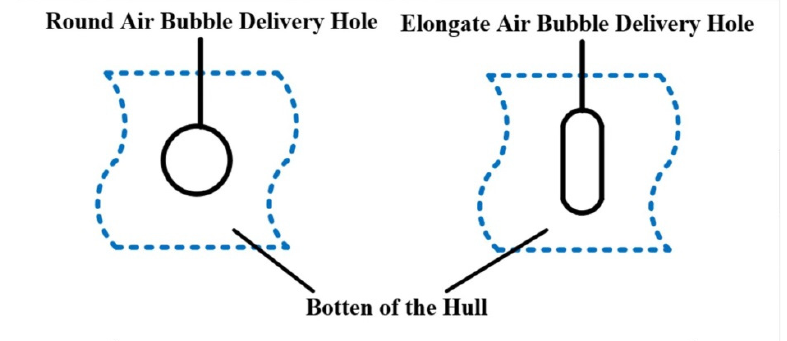
Figure 3. Forms of air vents of MHI Air Lubrication System.